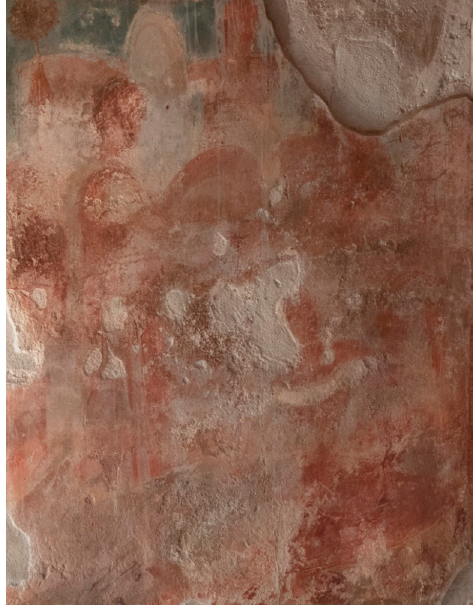
Figure 7. Victory of Bacchus. Image Courtesy: Kelly McClinton, 2017, on concession of the Ministero dei Beni e delle Attività Culturali e del Turismo, Parco Archeologico di Pompei (used by permission).